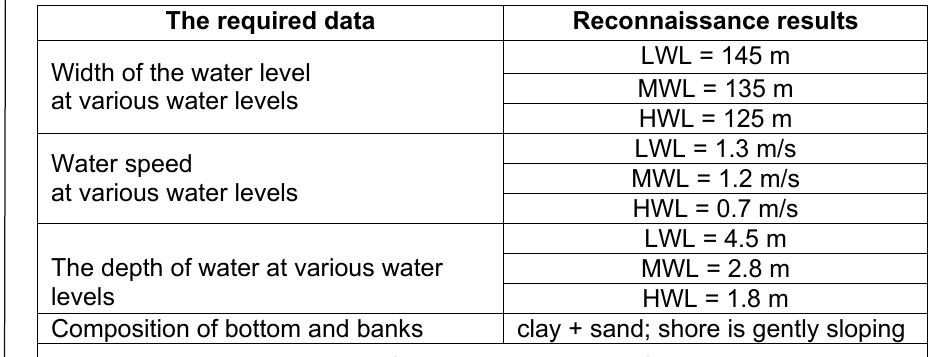
Table 2 – Data from the engineering reconnaissance Таблица 2 – Данные инженерной разведки Табела 2 – Подаци са инжињеријског